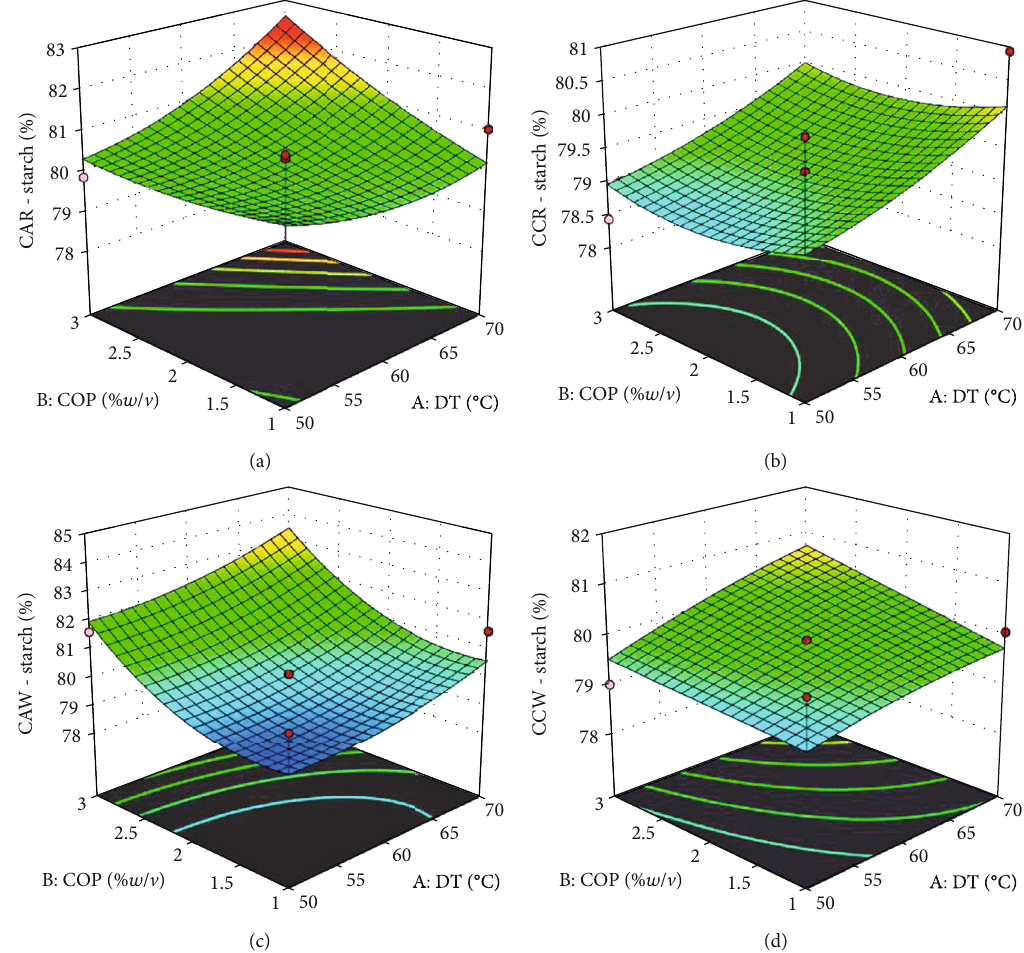
Figure 5: Response surface plots for starch content of cassava fl our. (a) Cassava from red landrace pretreated with citric acid. (b) Cassava from red landrace pretreated with calcium chloride. (c) Cassava from white landrace pretreated with citric acid. (d) Cassava from white landrace pretreated with calcium chloride. DT — drying temperature ( ° C); COP — concentration of pretreatment (% w / v ).